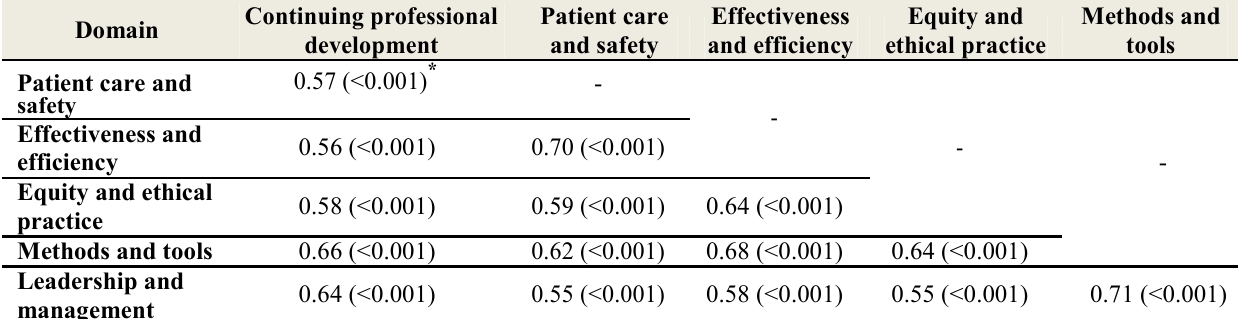
Table 2. Correlational matrix of subscale scores (alias domains of the instrument) Continuing professional